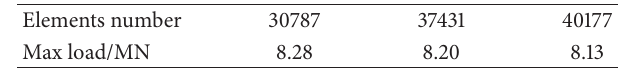
Table 1: Effect of the elements number on the maximum load. Elements